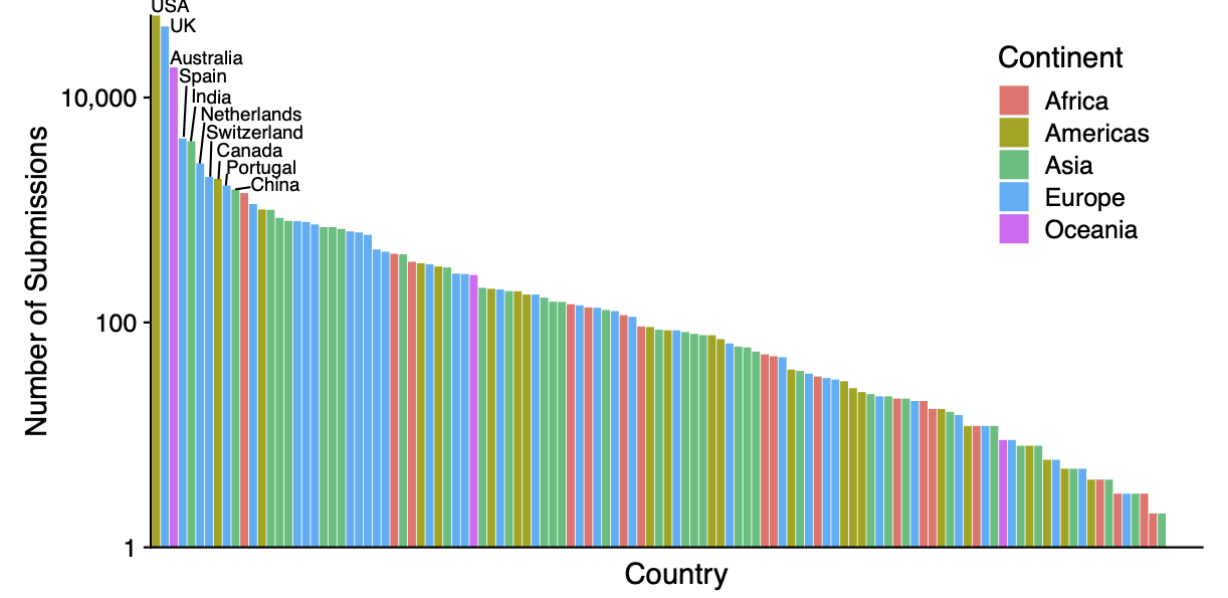
Figure 2. The number of submissions by country. The ten countries with the highest numbers of submissions are